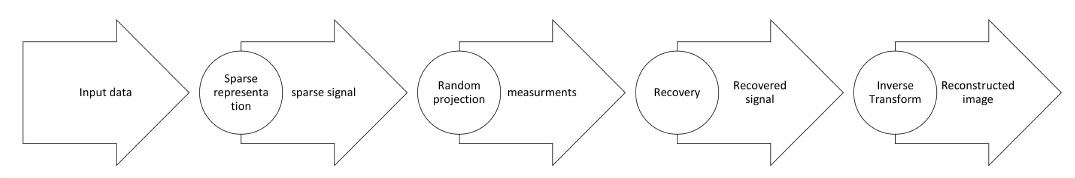
Figure 13. Main steps used in the compressive sensing-based class of HSI compression